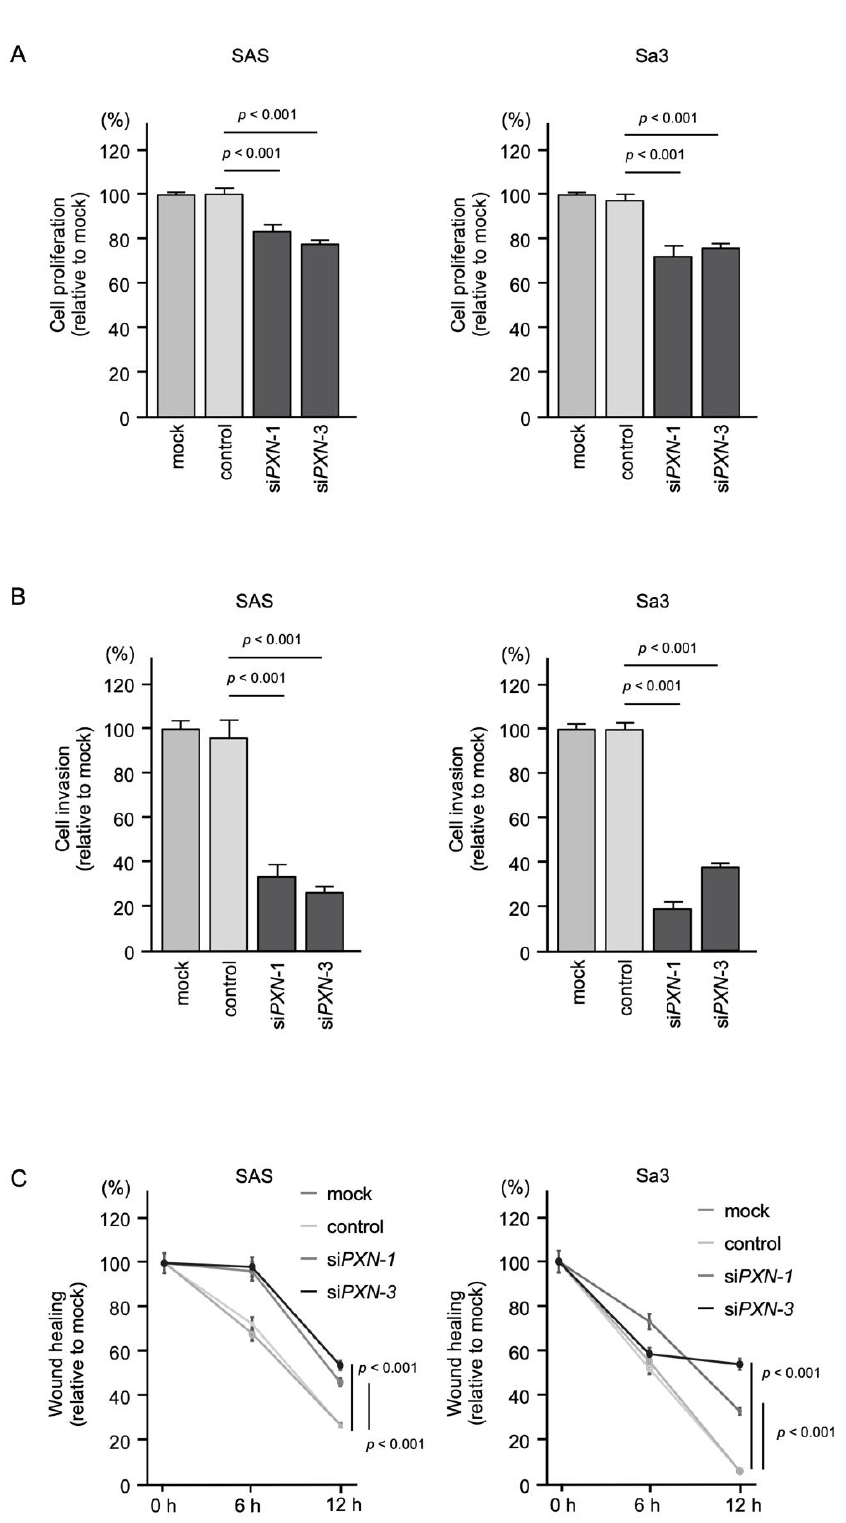
Figure 6. Functional assays of cell proliferation, invasion and migration following transient transfec- tion of siRNAs targeting PXN in HNSCC cell lines (SAS and Sa3 cells). ( A ) Cell proliferation assessed by XTT assay at 72 h after siRNA transfection. ( B ) Cell invasion assessed by Matrigel invasion assays at 48 h after seeding siRNA-transfected cells into chambers. ( C ) Cell migration assessed by wound healing assay at 0, 6, and 12 h after cell scratch formation.